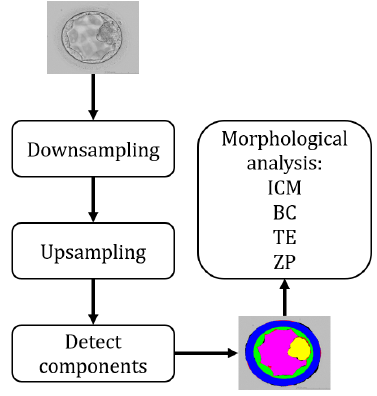
Figure 2. Overall summary of the proposed